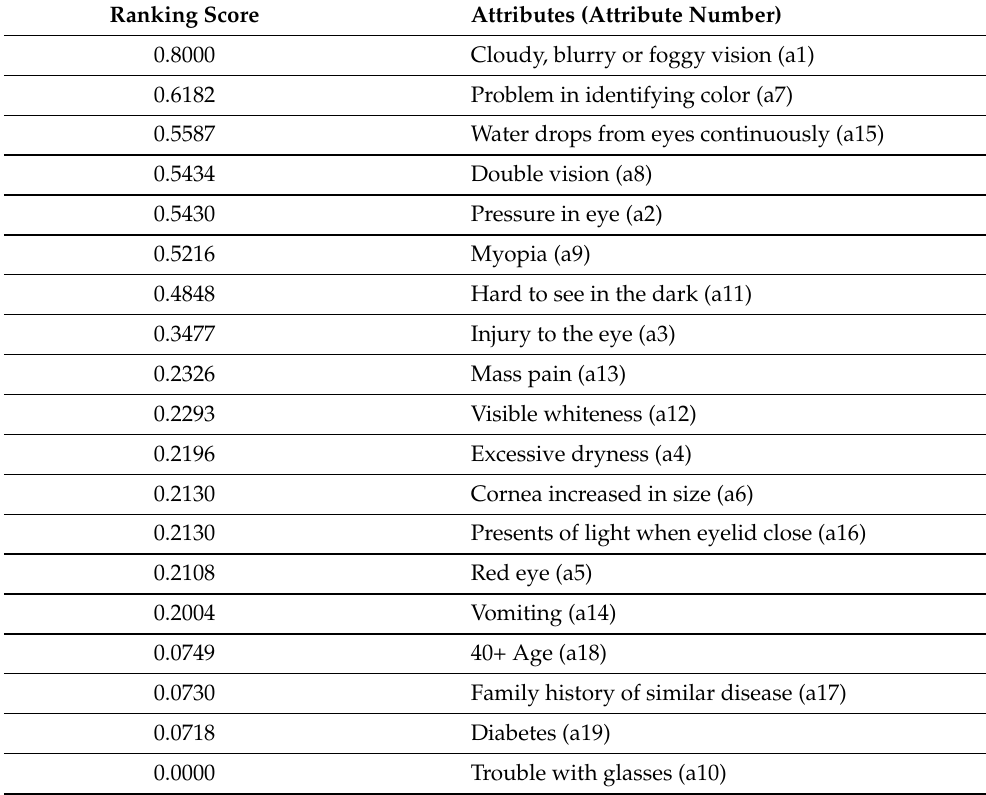
Table 4. Ranking of Features from Information Gain-based FS method.